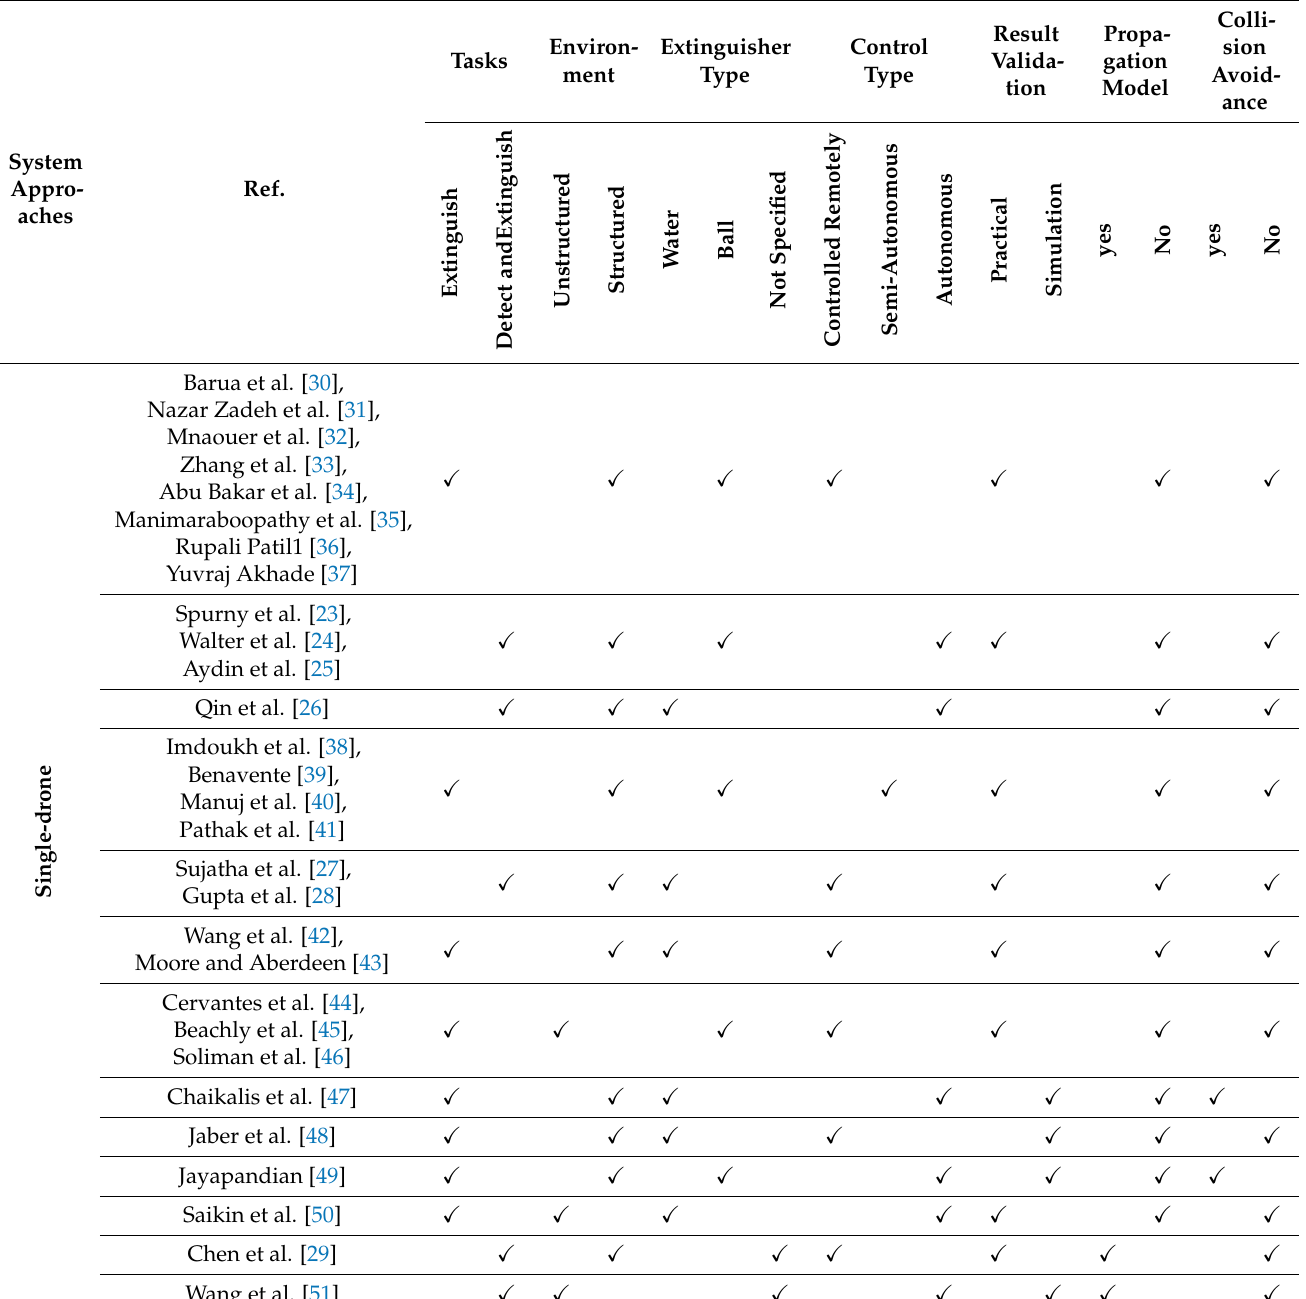
Table 8. Summary of fire-extinguishing systems using a single